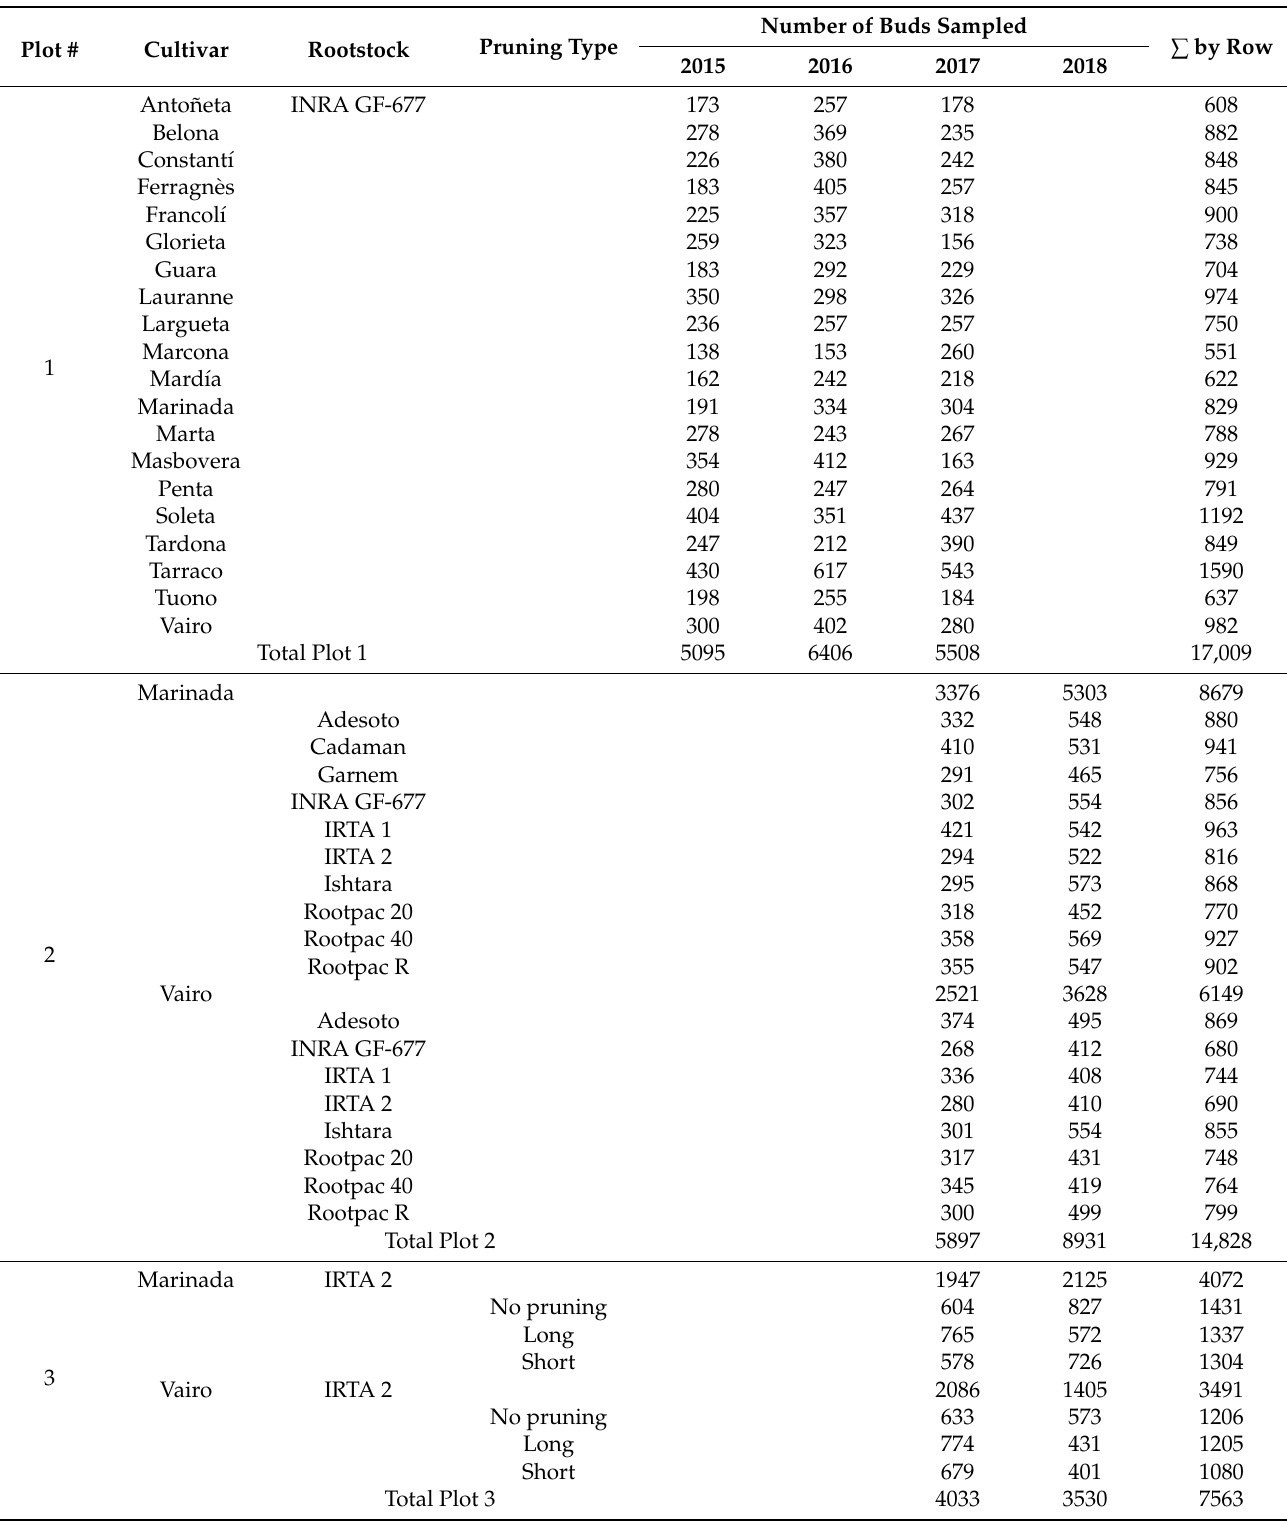
Table 1. Number of buds assessed per year (2015–2018) to calculate fruit drop rate for each cultivar, rootstock, and pruning type in each of the three plots at Les Borges Blanques,